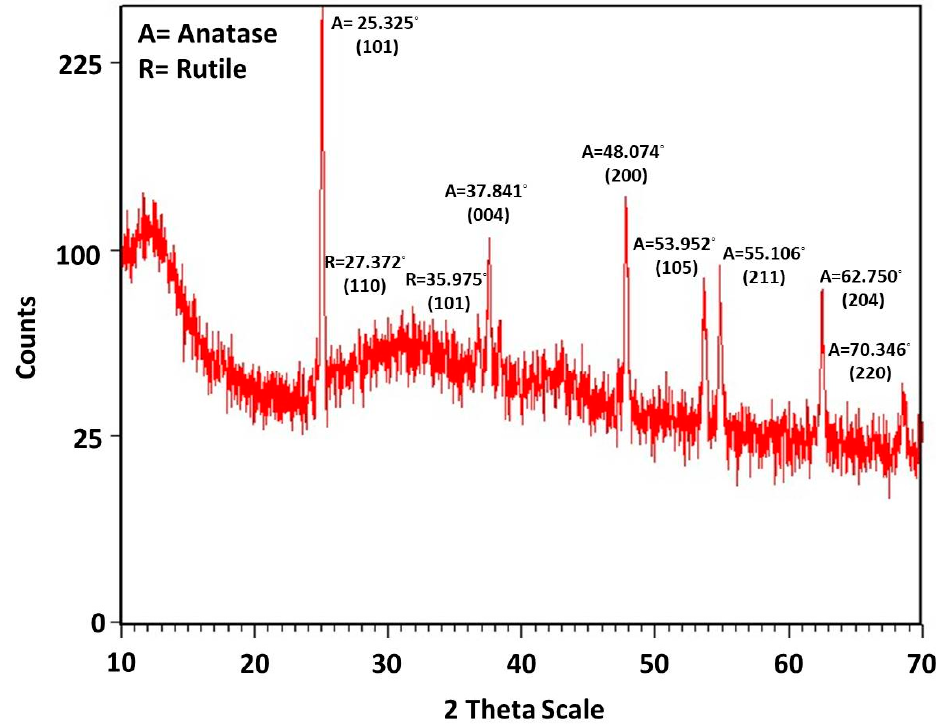
Figure 1. XRD pattern of TiO 2 nanoparticles synthesized by Bacillus subtilis .